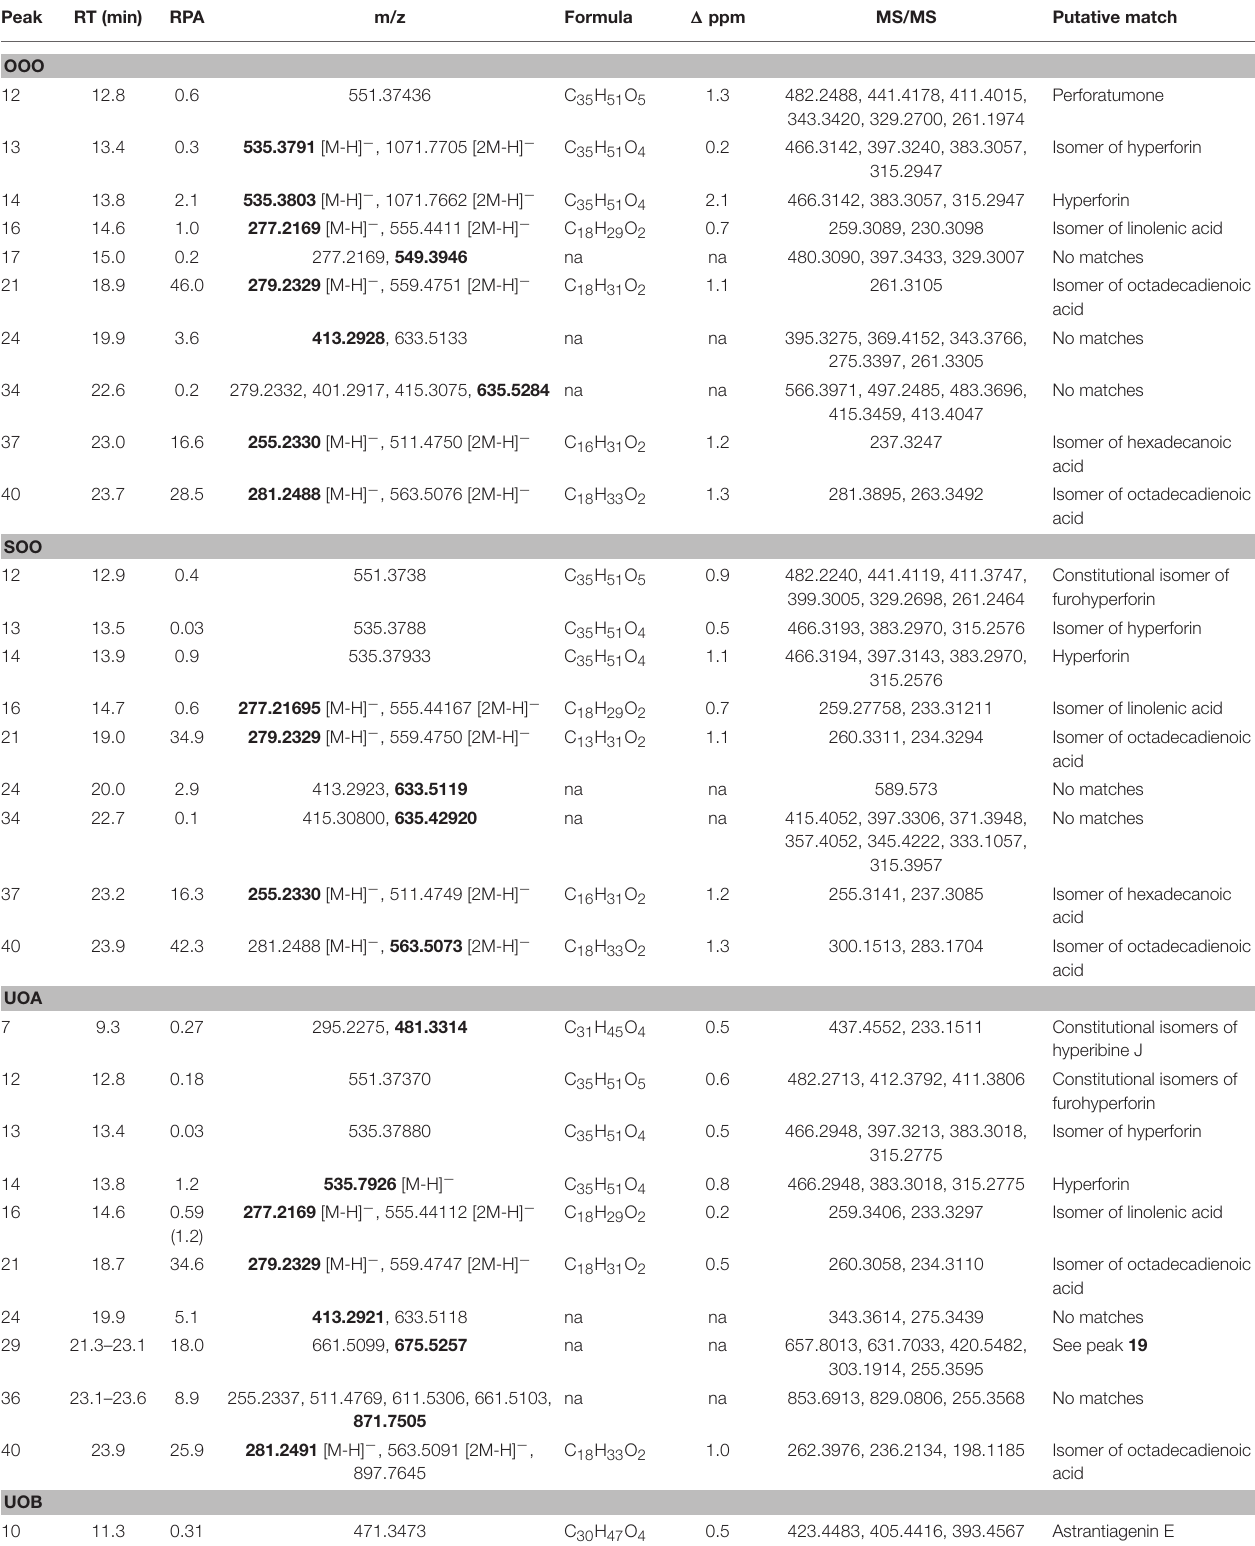
TABLE 5 | Mass spectrometry (MS) and MS/MS analysis of the peak data for oil macerates as reported in Figure 8 .